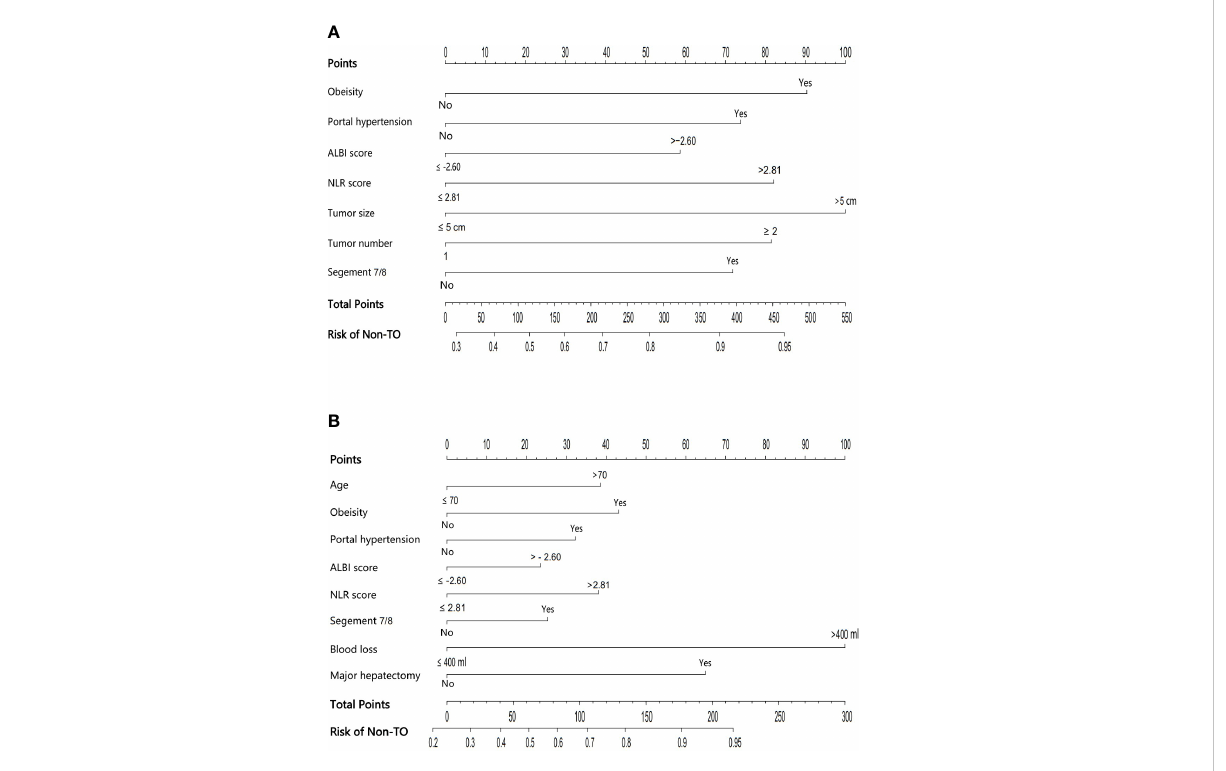
FIGURE 2 The preoperative (A) and postoperative (B) nomogram models for predicting